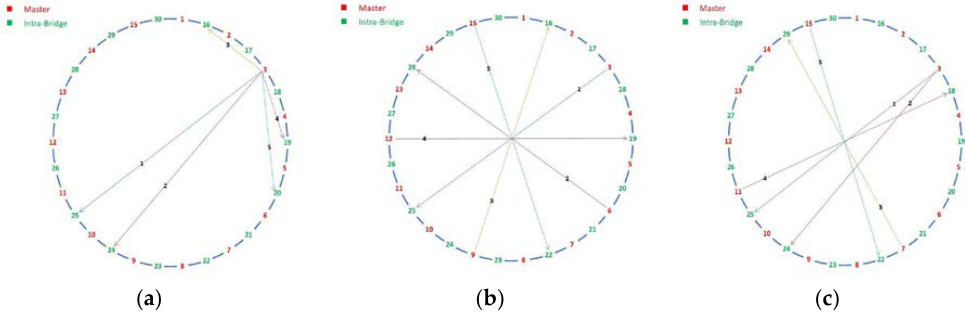
Figure 6. The piconet case of Mesh-Ring topology ( a ); the scatternet case of Mesh-Ring topology ( b ); the hybrid case of Mesh-Ring topology ( c ).